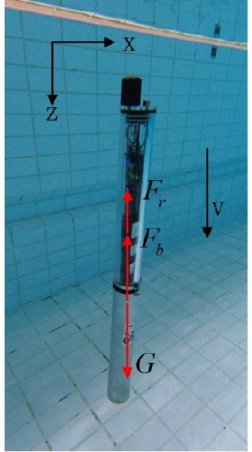
Figure 2. Main forces acting on a moving float.